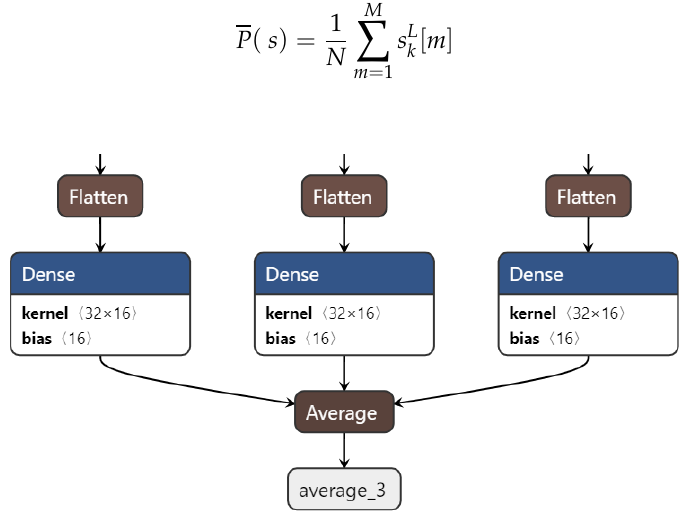
Figure 3. Ensemble CNN.